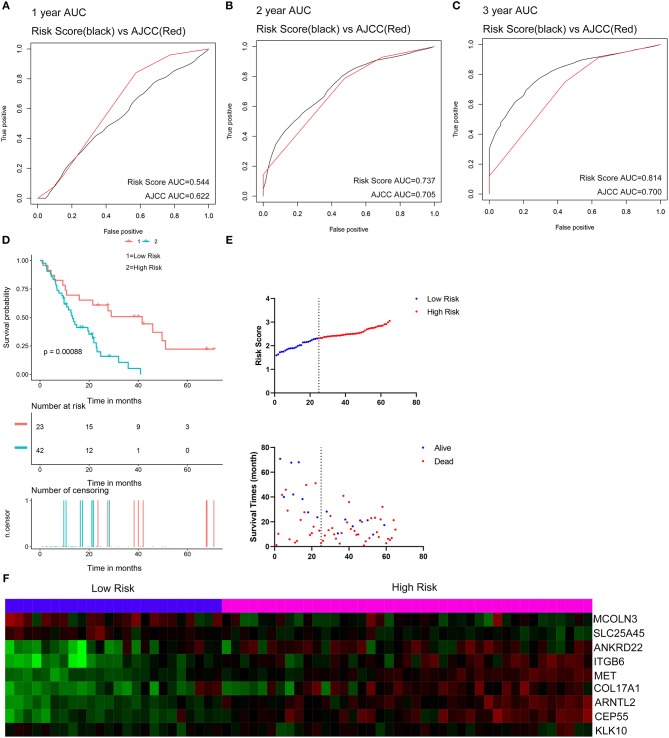
External validation of the nine gene signature in GSE62452 dataset. (A–C) Show the ROC curves for 1-, 2-, and 3-year overall survival predictions for the nine gene signature in compare with AJCC stage. (D) shows the Kaplan-Meier survival curves of the nine gene signature. Patients from the GSE62452 dataset are stratified into two groups according to the optimal cut-off values for the risk scores calculated by X-Tile. (E,F) Distribution of the risk score and the associated survival data and mRNA expression heat map in GSE62452 dataset.